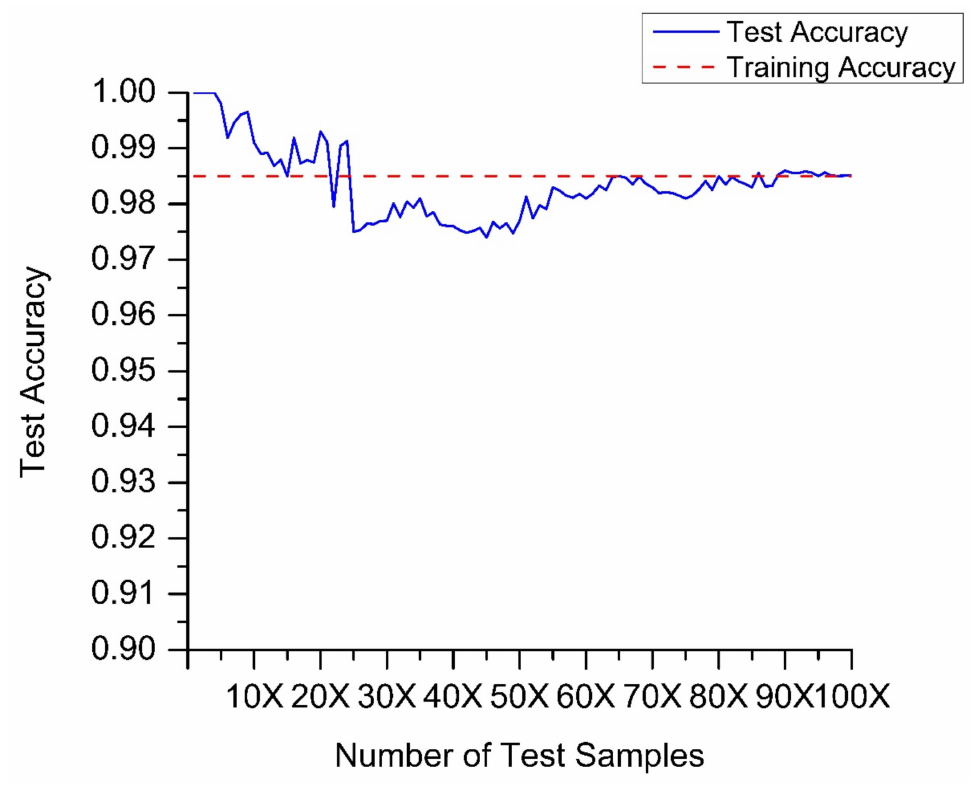
Figure 24. The Stability of Improved